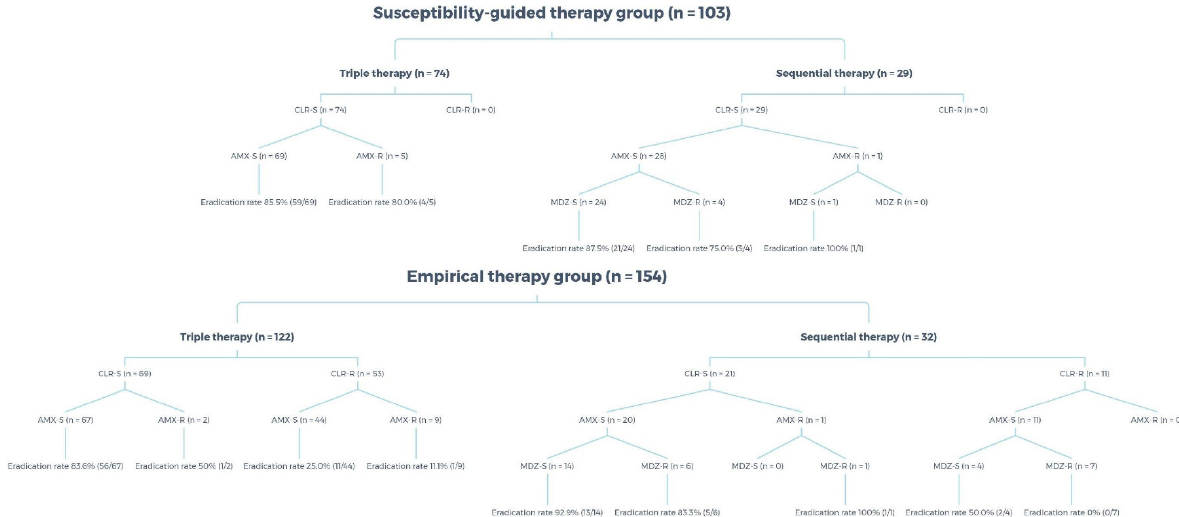
Figure 3. Antimicrobial susceptibility of the susceptibility-guided therapy and the empirical therapy groups. CLR, clarithromycin; AMX, amoxicillin; MDZ, metronidazole; S, susceptible; R, resistant.